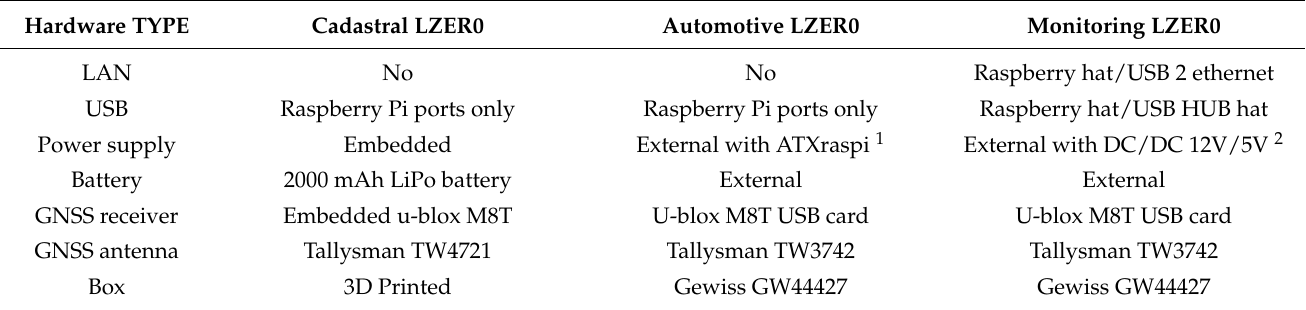
Table 1. Hardware used to manufacture the various LZER0 models, all of them including a Raspberry Pi Zero W with Wi-Fi and BT embedded in the SBC. The motherboard for cadastral applications was developed by OGS and includes the power supply system, u-blox M8T GNSS receiver, power supply, and battery-charging system. For automotive and monitoring applications, OGS developed a USB card in the form of a Raspberry Pi hat that includes the u-blox M8T GNSS receiver. The USB card can also be used directly on a Personal Computer (PC) as a convenient portable GNSS